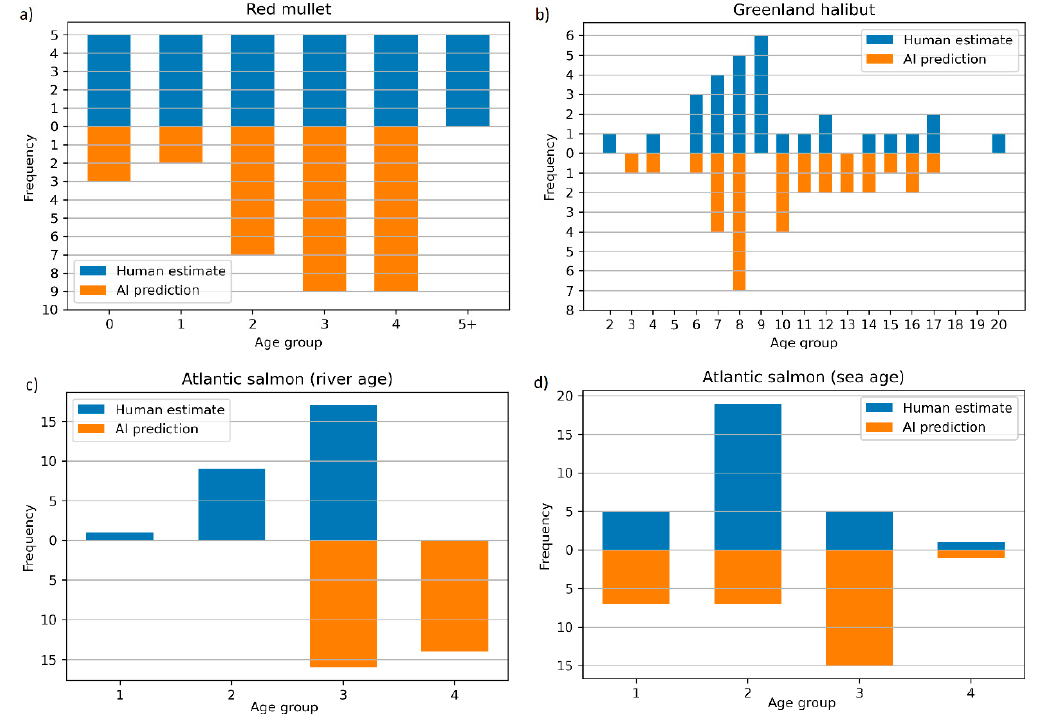
Figure 5. Age frequency distributions of human estimates against AI predictions for ( a ) red mullet ( Mullus barbatus ), ( b ) Greenland halibut ( Reinhardtius hippoglossoides ), ( c ) Atlantic salmon ( Salmo salar ; river age), and ( d ) Atlantic salmon ( Salmo salar ; sea age). For each species, we used a dataset of 30 images.